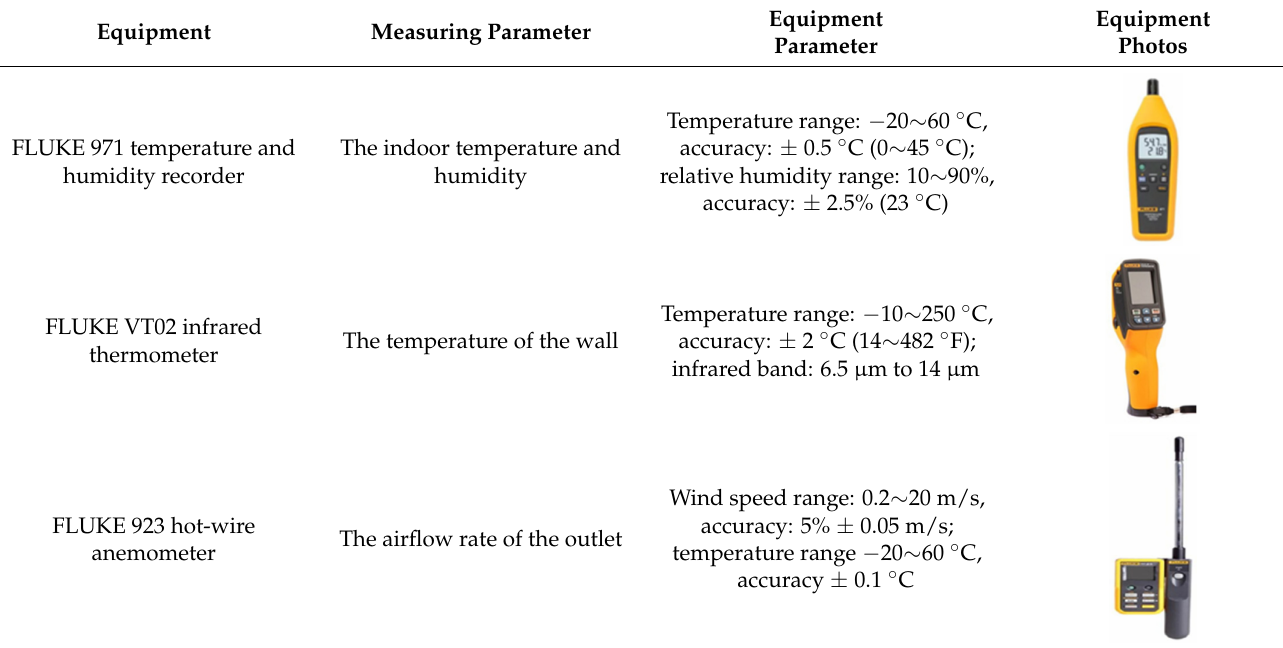
Table 2 lists the instrument types and related errors for the test. Table 2. Measurement